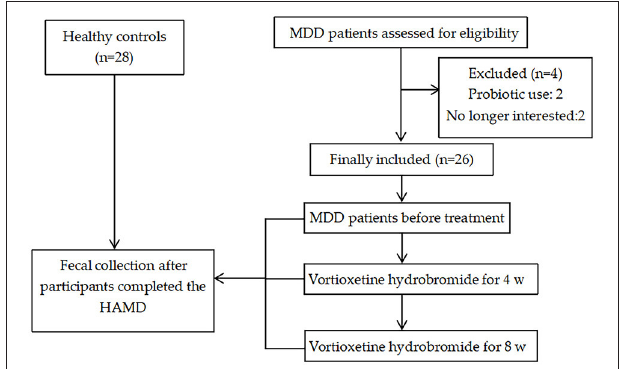
FIGURE 1 | Flowchart for participant recruitment and sample collection process.